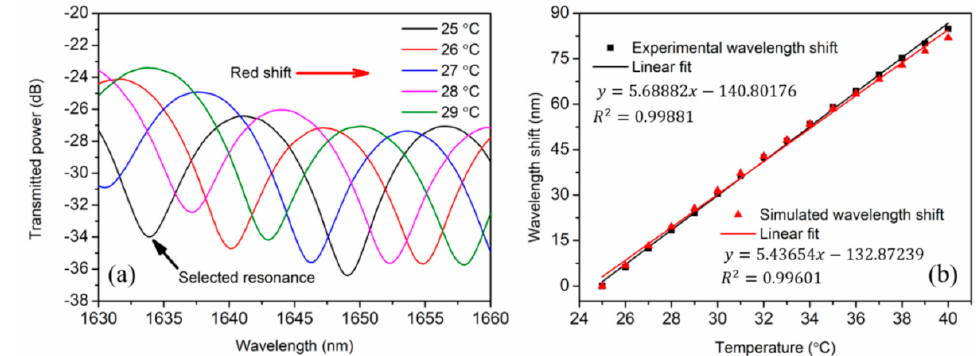
Figure 5. ( a ) Partial transmitted spectrum evolution of the sensor measured in the temperature range of 25 to 29 ◦ C. The length of the infiltrated glycerol–water solution is 29.5 cm; ( b ) experimental and simulated wavelength shift of the spectral dip at ~1634 nm as a function of temperature in the range of 25 to 40 ◦